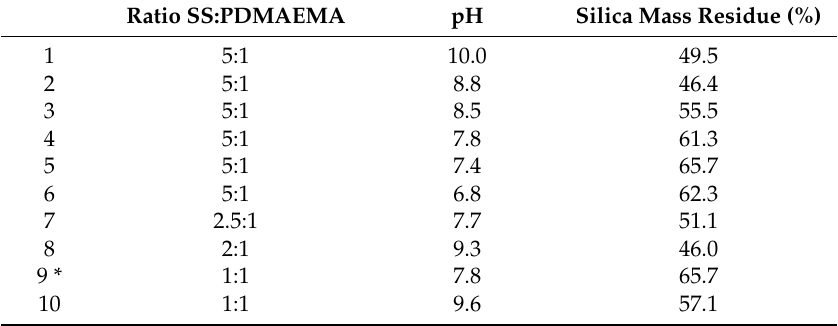
Table 2. Thermogravimetric Analysis (TGA) of S-PDMAEMA 60 precipitates except 9 *, which is water-dispersible S-PDMAEMA 60 isolated by ultrafiltration. The pH at which S-PDMAEMA 60 formation was initiated is shown, as well as the feed ratio of SS/PDMAEMA. (For examples of the TGA plots,